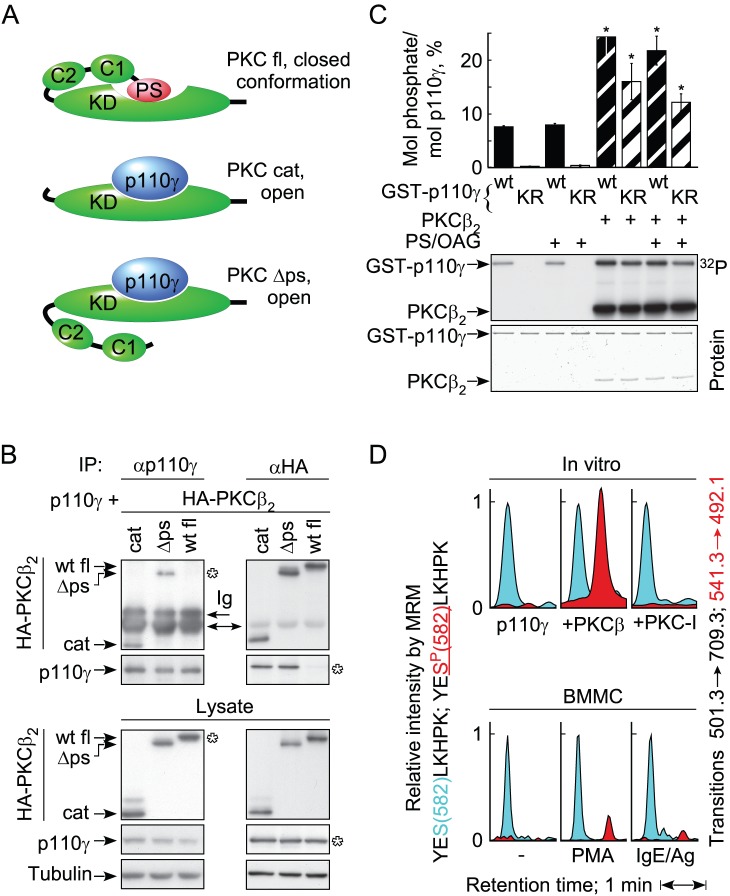
PKCβ interacts with and phosphorylates the catalytic subunit of PI3Kγ.(A) Schematic representation of the PKCβ-p110γ interaction: full-length (fl) PKCβ is in a closed conformation due to the interaction of the pseudo-substrate domain with the catalytic pocket of PKCβ, while the truncated catalytic domain (cat; amino acids 302–673) and pseudo-substrate deletion mutant (Δps; deletion of aa 19–31) give access to p110γ. (B) HEK293 cells were co-transfected with p110γ and HA-tagged PKCβ2 constructs. Protein complexes were immunoprecipitated with anti-p110γ or anti-HA antibodies, before HA-PKCβ2 and p110γ was detected by immunoblotting. Ig: immunoglobulin heavy chain signals of mouse anti-p110γ and anti-HA antibodies. (C) Recombinant GST-p110γ wild type (wt) or a catalytically inactive p110γ mutant (KR, Lys833Arg mutant) were incubated with recombinant PKCβ2 and [γ32P]-ATP in kinase buffer for 30 min, before proteins were denatured and separated by SDS-PAGE. Phosphatidylserine (PS) lipid vesicles containing 1-oleoyl-2-acetyl-sn-glycerol (OAG) were present during the reaction where marked. Protein-bound 32P was determined by radioisotope imaging, and recombinant proteins were stained with Coomassie blue (mean ± standard error of the mean [SEM], n = 3; * point to comparison with respective sample without PKC). (D) In vitro and in vivo phosphorylation of PI3Kγ on S582, analyzed by LC-MRM. S582 non-phospho- and phospho-peptides were detected in the MRM mode, quantifying the transition 501.1 to 709.3 for the non-modified peptide (blue) and 541.3 to 492.1 for the phospho-peptide (red). Data were normalized to the transition of the non-modified peptide, which was set to 1. Upper part: recombinant catalytically inactive human GST-PI3Kγ (2 µg) was incubated alone, together with PKCβ2 or with PKCβ2 and PKC-inhibitor (Ro318425, 2 µM) as in (C). After SDS-PAGE and Coomassie staining, PI3Kγ was excised from the gel and prepared for LC-MRM. Lower part: wild type BMMCs (300 M cells/stimulation) were starved for 4 h in IL-3 free medium/2% FCS, and were left unstimulated or were treated for 2 min with 50 nM PMA or for 4 min with 10 ng/ml antigen (cells preloaded with 100 ng/ml IgE overnight). Endogenous PI3Kγ was immunoprecipitated from cell lysates, resolved by SDS-PAGE and analyzed with LC-MRM.